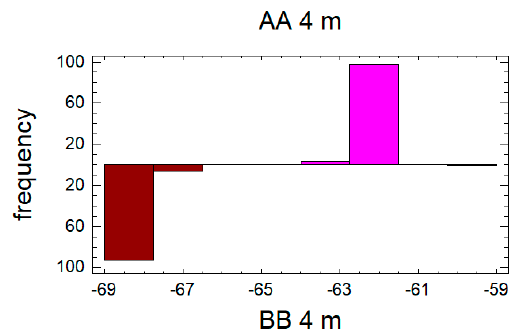
Figure 6. Histogram for reading distance 4 m.